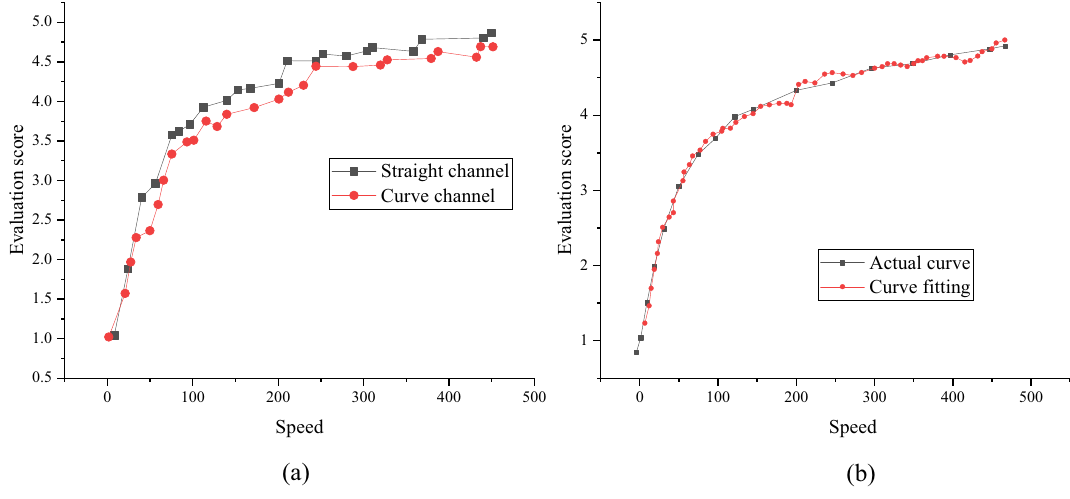
Fig. 7 Dizziness degrees in the central rotation motion scene ( a dizziness comparison results in the scene of the linear channel and curve channel; b curve fitting